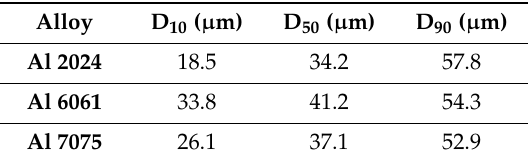
Table 2. Powder size distribution-related values associated with the rapidly solidified aluminum alloys considered herein: Al 2024, Al 6061, and Al